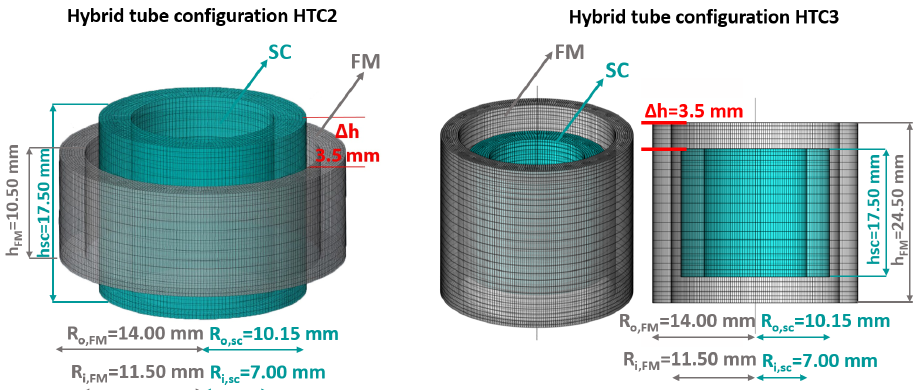
Figure 4. Schematic view of the tubular hybrid layouts consisting in SC/FM superimposed tubes with the SC tube protruding above the FM one (HTC2) and in SC/FM superimposed tubes with the FM tube protruding above the SC one (HTC3). The shield sizes are reported in the picture, where R o and R i are the outer and inner radii of the tubular layouts, respectively; ∆ h represents the height difference between the tubes